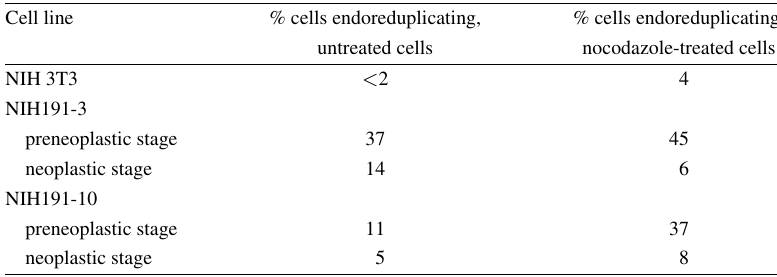
Spindle assembly check-point function in NIH 3T3 and HCV core-expressing NIH 3T3 Neo r